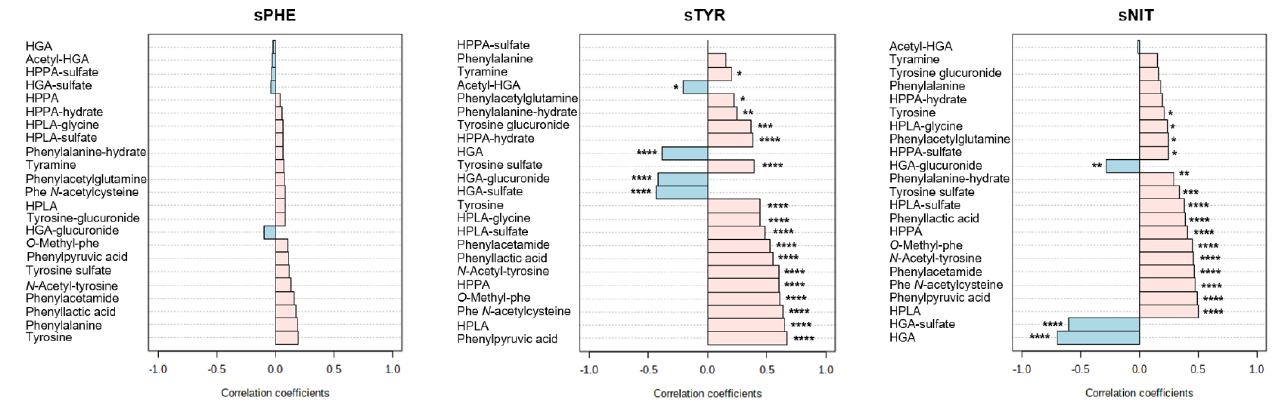
Figure 4. Data from Pearson correlations between urine metabolite abundance and corresponding serum biochemical concentrations of phenylalanine (sPHE), tyrosine (sTYR) and nitisinone (sNIT). Pink and blue bars represent positive and negative correlations, respectively. Data are from samples from patients on nitisinone treatment only; visits 4 and 6 combined. Figures produced using MetaboAnalyst (version 5.0) [29]. * p < 0.05, ** p < 0.01, *** p < 0.001, **** p < 0.0001.